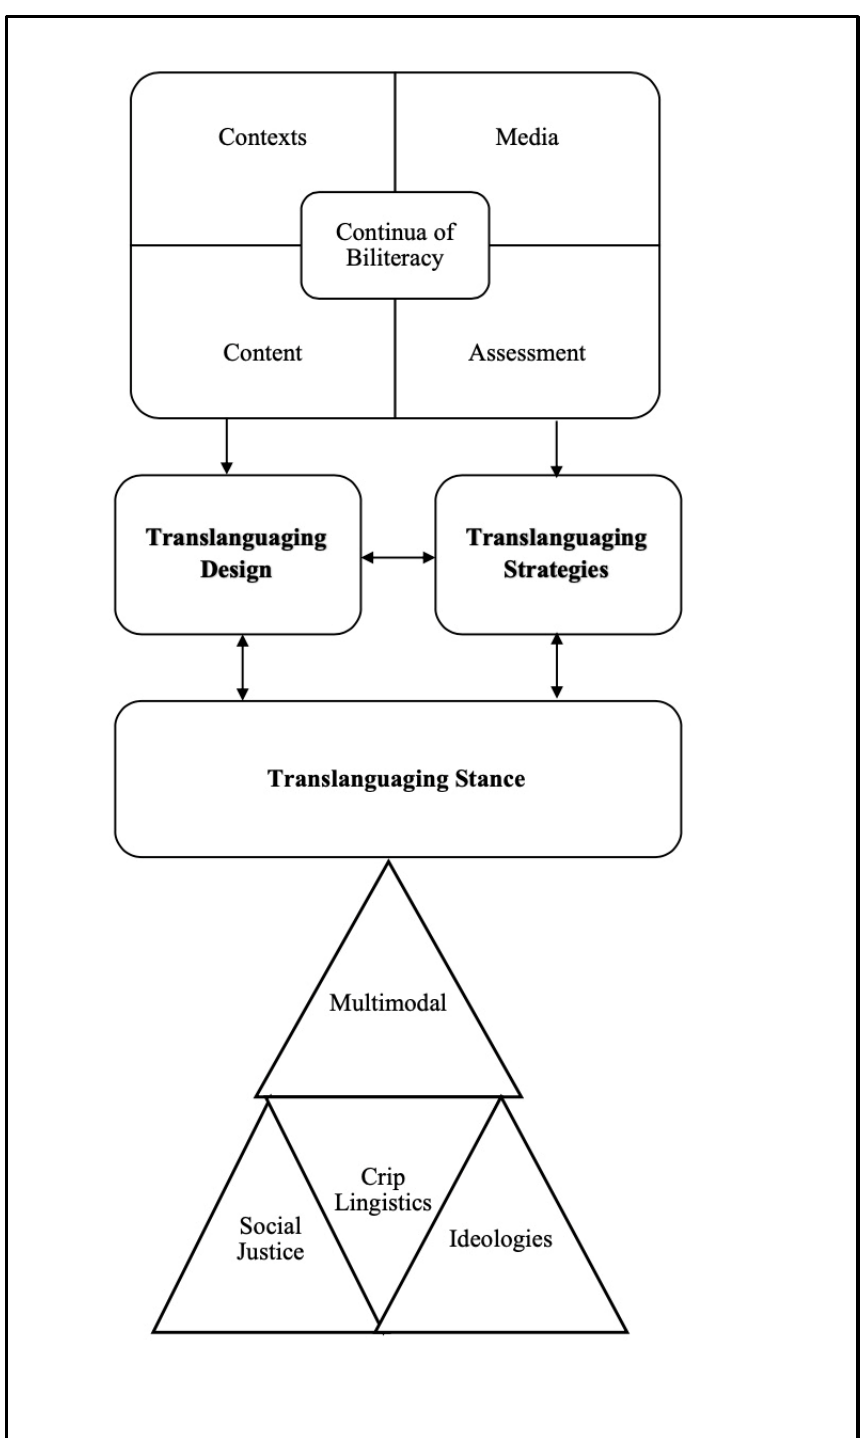
Figure 1. The Building Blocks of translanguaging pedagogy in Deaf teacher education.